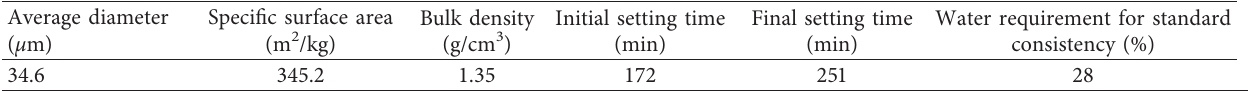
Table 3: Physical properties of